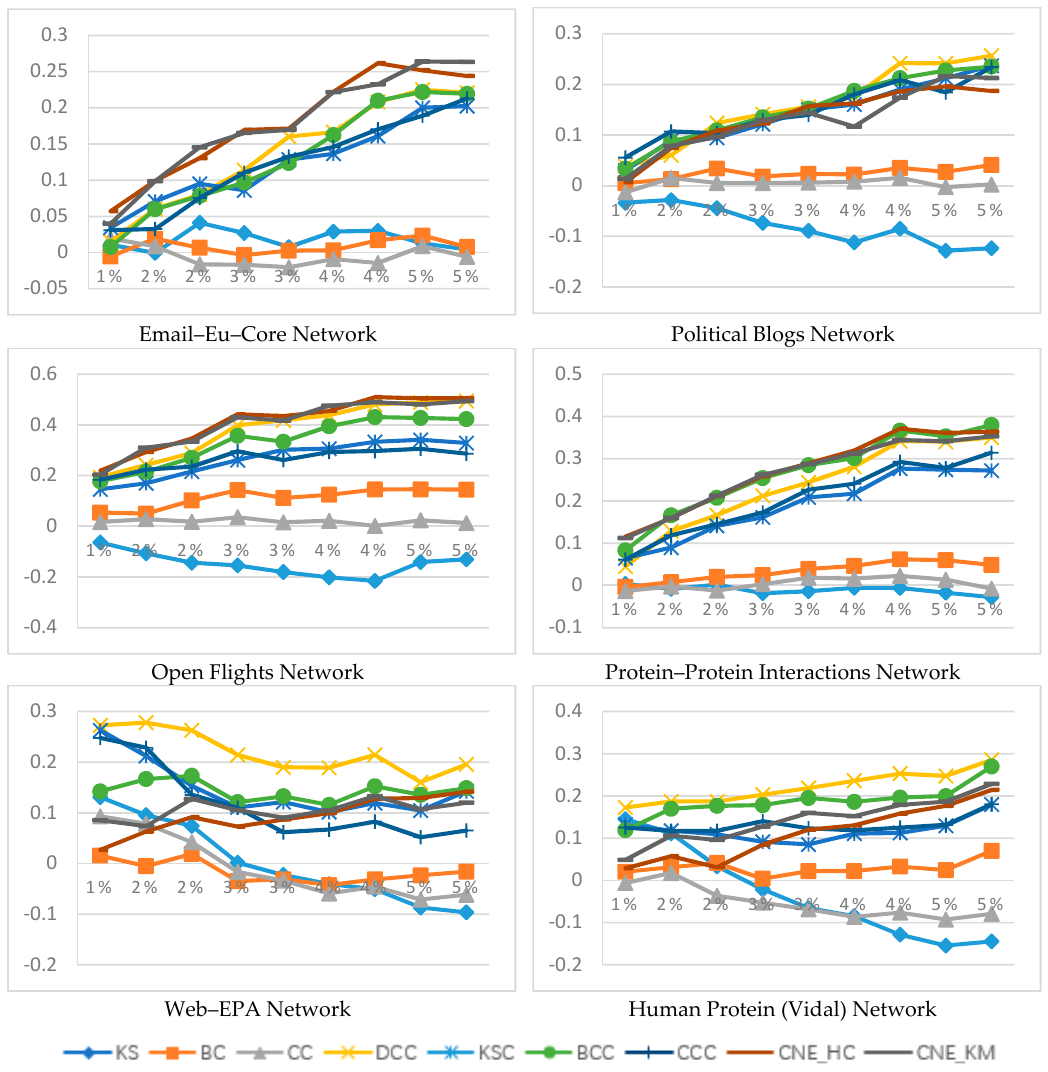
Figure 6. Set the infection rate β = 0.2, and the relative ratio Φ of infection rate V varies with the number of nodes m, repeating the experiment 500 times independently.